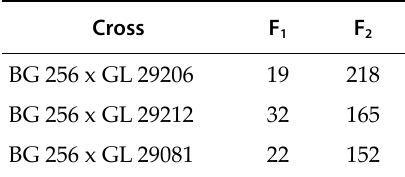
Table 5. Populations developed from derivative lines and a susceptible chickpea ( C. arietinum )